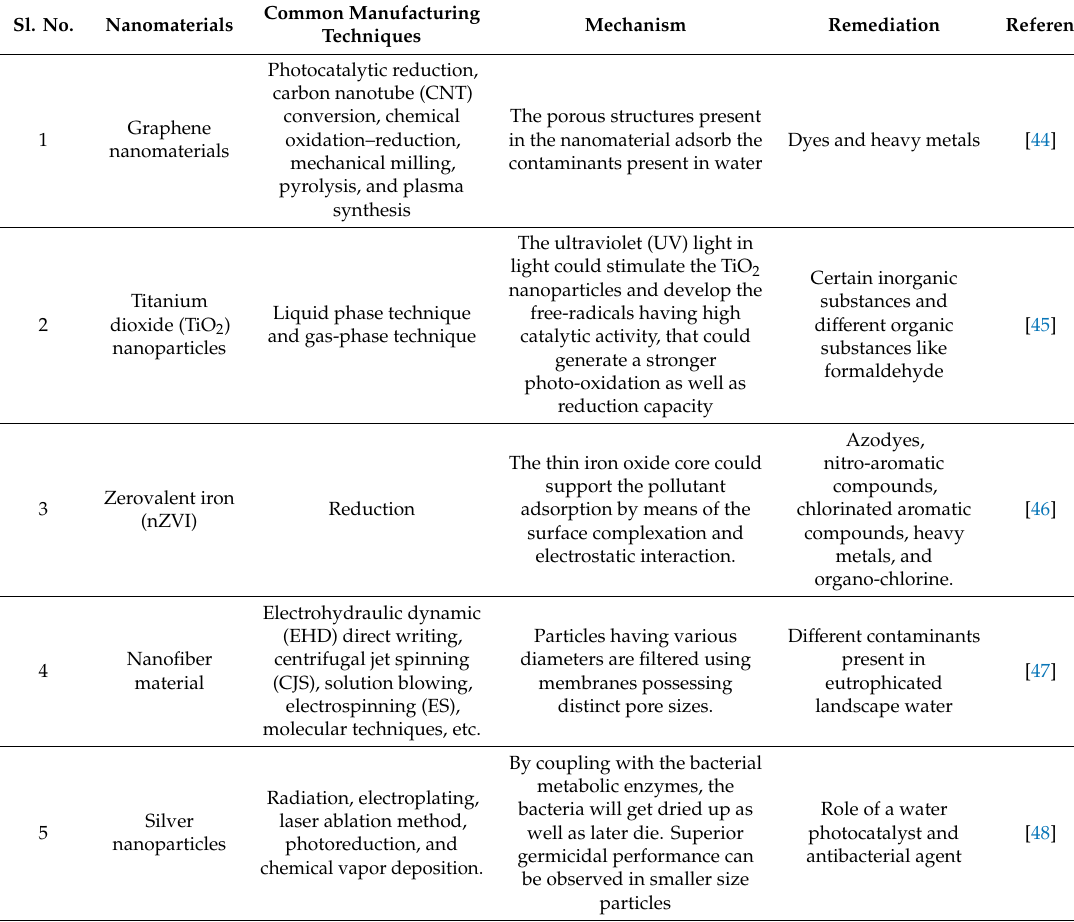
Table 1. Application of various nanomaterials in the remediation of water contamination. Sl.